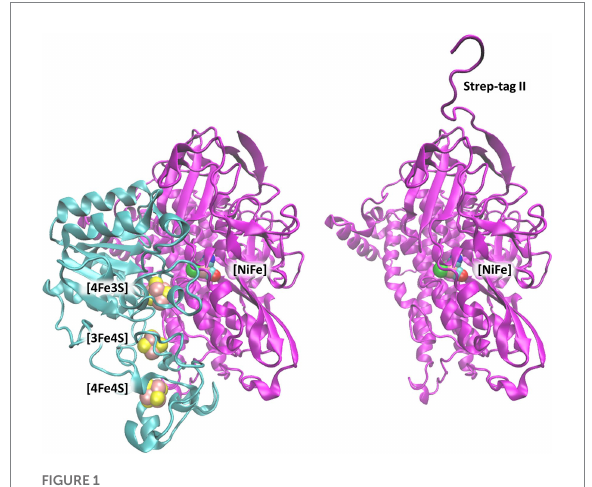
FIGURE 1 [NiFe]-hydrogenase from C. necator (PDB code: 3RGW (Fritsch et al., 2011)). Left : Heterodimer consisting of the small subunit (HoxK, colored cyan) and large subunit (HoxG, colored magenta). Right : Isolated large subunit (HoxG) with its Strep-tag II sequence located at the N terminus (Caserta et al., 2022a). [NiFe]-active site and [FeS]-clusters are shown as spheres and depicted with the following color code: Fe in pink, Ni in green, S (from Cys) in yellow, CN-and CO groups, cyan-blue and cyan-red,